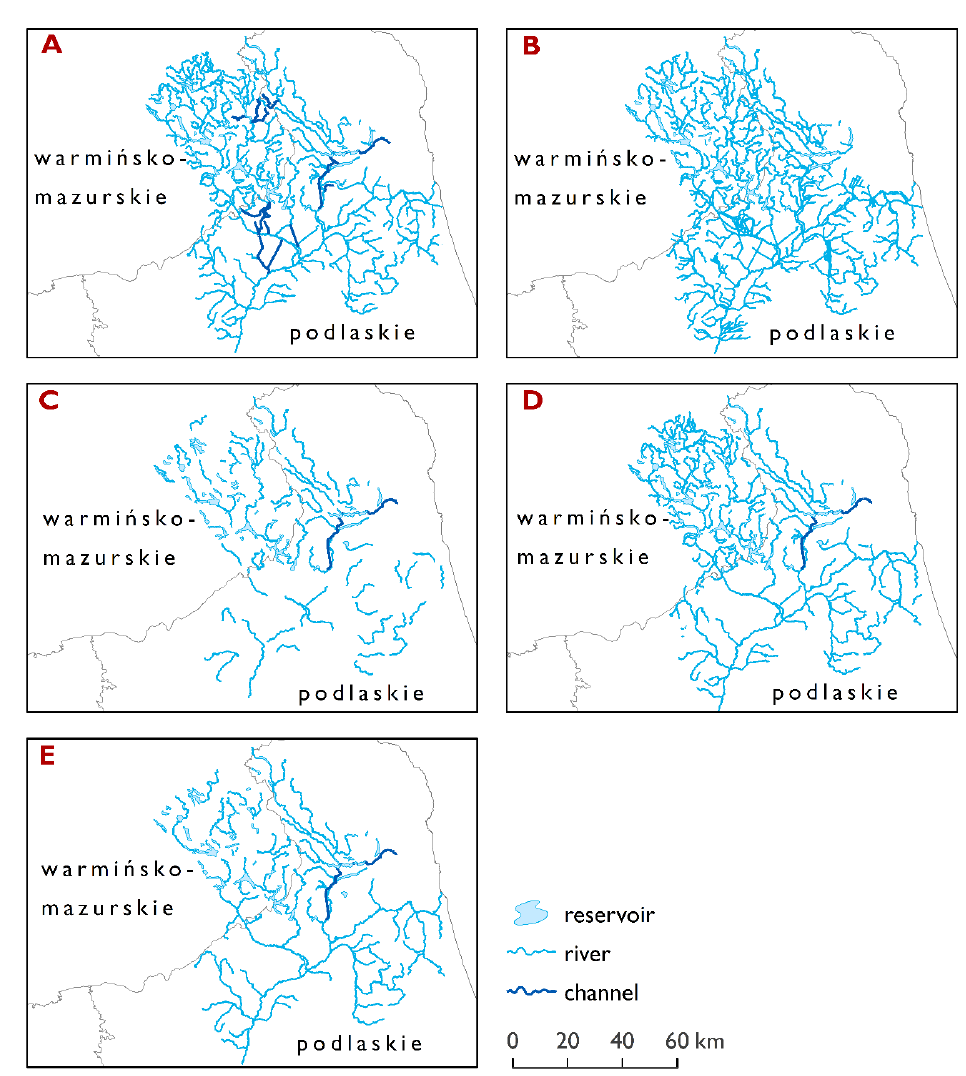
Fig. 7. The results of the generalization of the biebrza basin. A – source data, b – vectorized data from the reference atlas map, C – selection according to the regulation, D – selection according to the regulation using the idMPHP index, E – selection according to the regulation with the use of